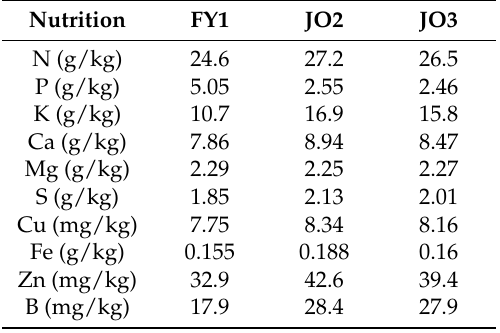
Table 2. The nutritional levels in leaves of Jianou 2 (JO2), Jianou 3 (JO3), and Fuyang 1 (FY1) varieties.